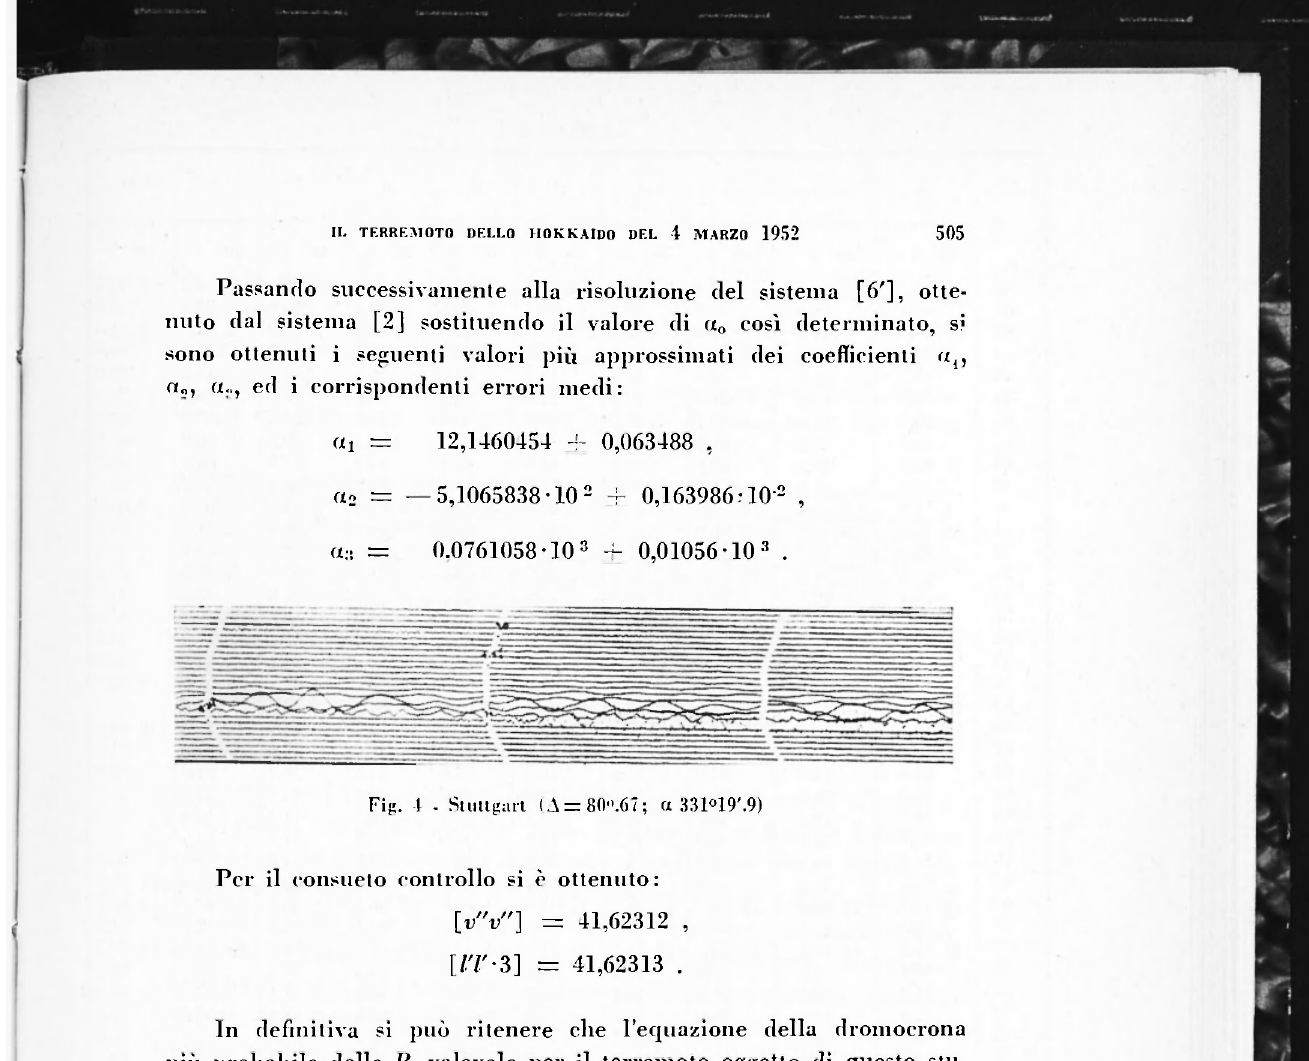
Fig. 4 - Stuttgart <A= 80".67; a